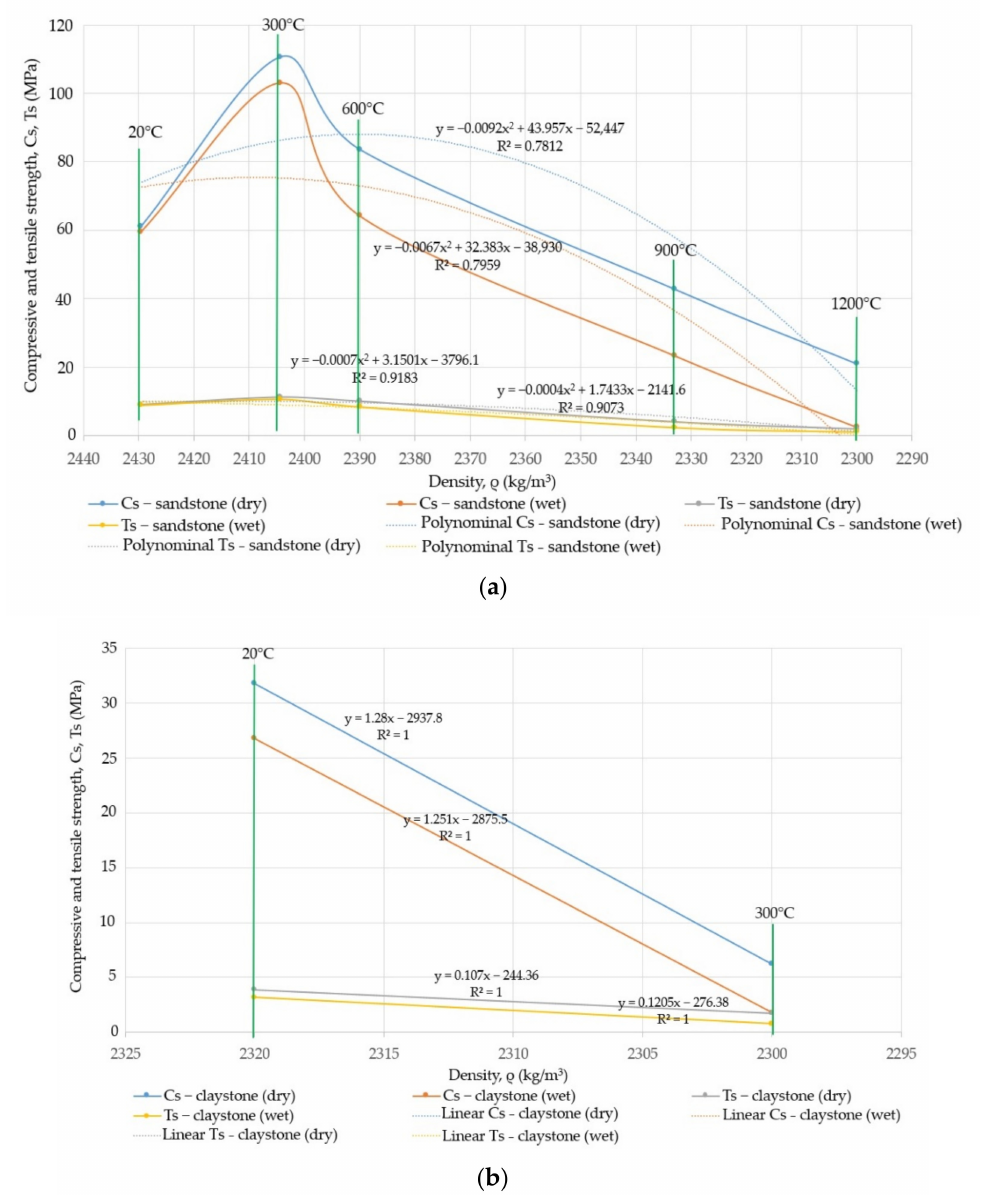
Figure 18. The dependence of the compressive strength and tensile strength in relation to the decrease in density for: ( a ) sandstone; ( b )